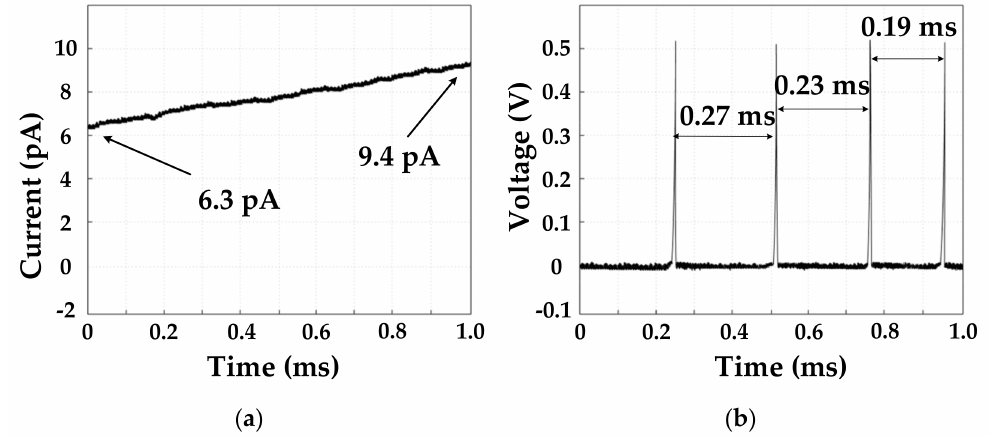
Figure 14. The input and output waveforms of the designed artificial retinal neuron circuit based on the fabricated chip. The different spikes correspond to different input currents. ( a ) The waveform of the input current, in which the amplitude of the input current is increased from 6.3 pA to 9.4 pA. ( b ) The output waveform, in which the output spike voltage is generated by different time